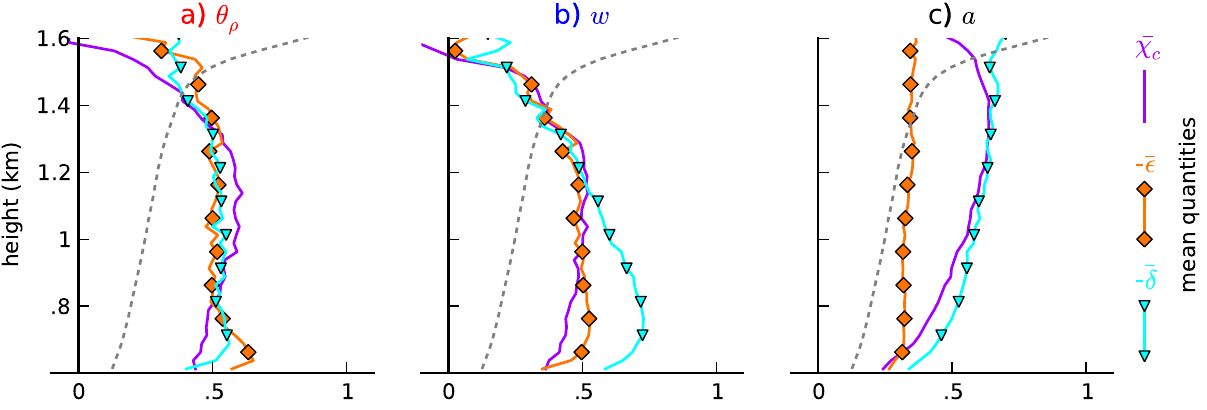
Fig. 13. Correlation profiles between cloud properties at each level and the mean of the entrainment/detrainment variables from cloud base at 600m to the current level for (a) density potential temperature θ ρ , (b) vertical velocity w , and (c) horizontal cross-sectional area a . Yellow triangles show correlations with mean critical mixing fraction ¯ χ c , orange diamonds show correlations with the negative of the mean fractional entrainment rate ¯ (cid:15) , and cyan triangles show correlations with the negative of the mean fractional detrainment rate ¯ δ . Dotted lines show the 99% confidence level for a correlation to be significantly different than